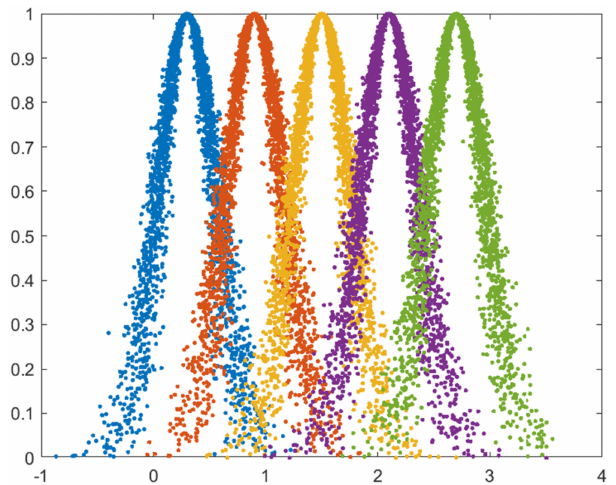
Figure 6. Retail sales of social goods per capita.